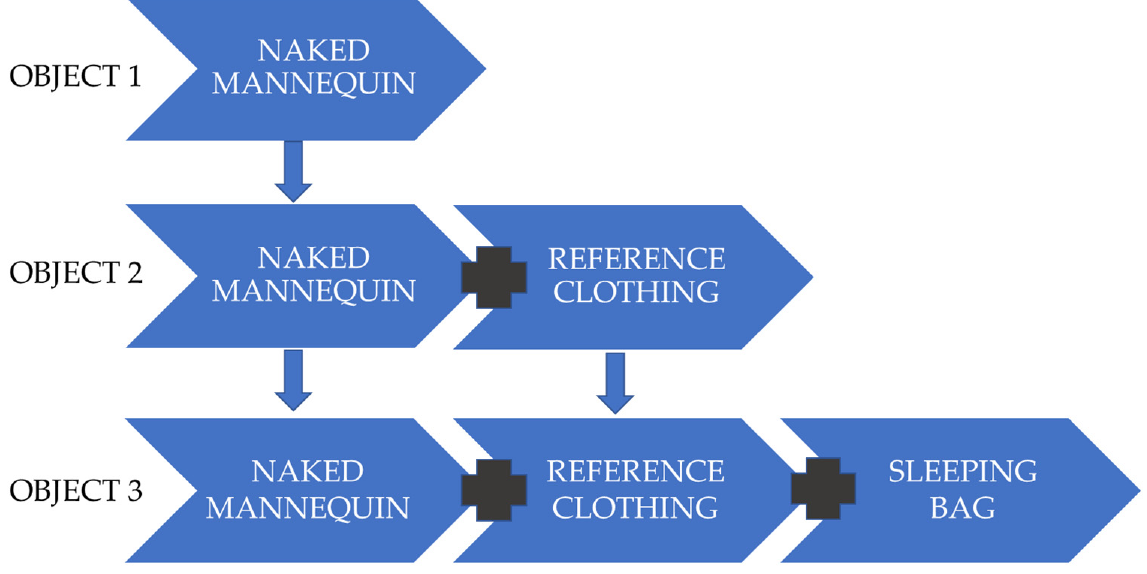
Figure 2. Graphical representation of the objects